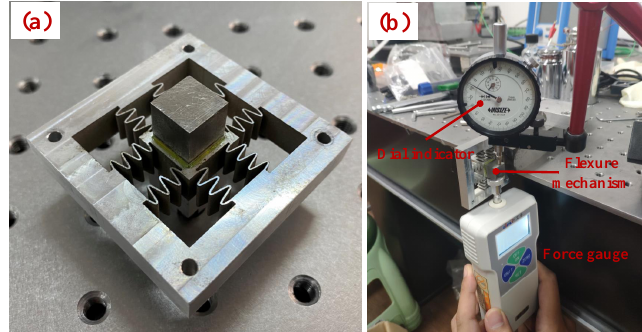
Figure 8. Photograph of ( a ) the mechanism prototype and ( b ) the experimental setup for stiffness measurement.